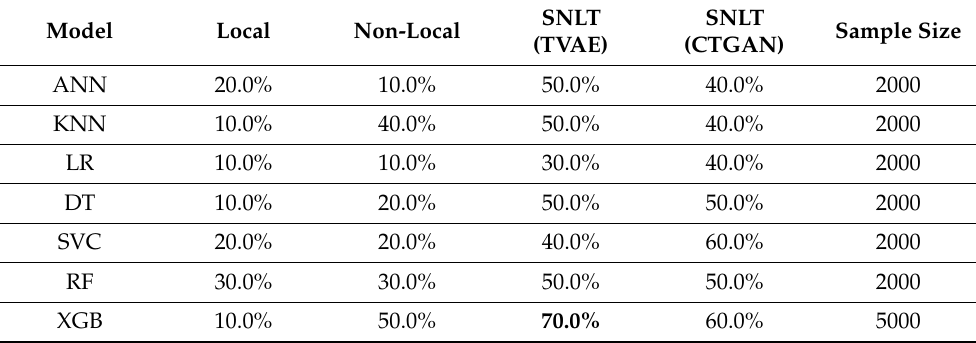
Table 6. Train SD, test OH with 10 samples: best accuracies (bold) from OH local training, non-local training (SD), and SNLT with CTGAN and TVAE (SD), each for three class labels (high, medium, and low yield), plus size of synthesized dataset.